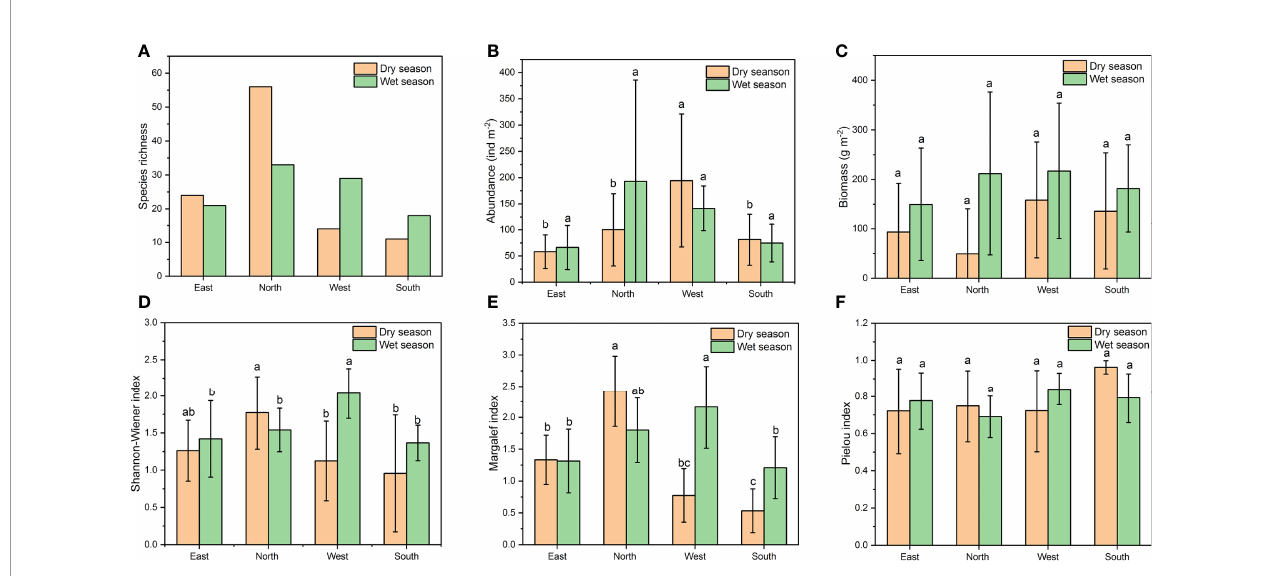
FIGURE 3 | Species richness (A) , abundance (B) , biomass (C) , and diversity indices [ (D) Shannon-Wiener index; (E) Margalef index; (F) Pielou index] for the mangrove benthic macrofaunal communities on Hainan Island in different